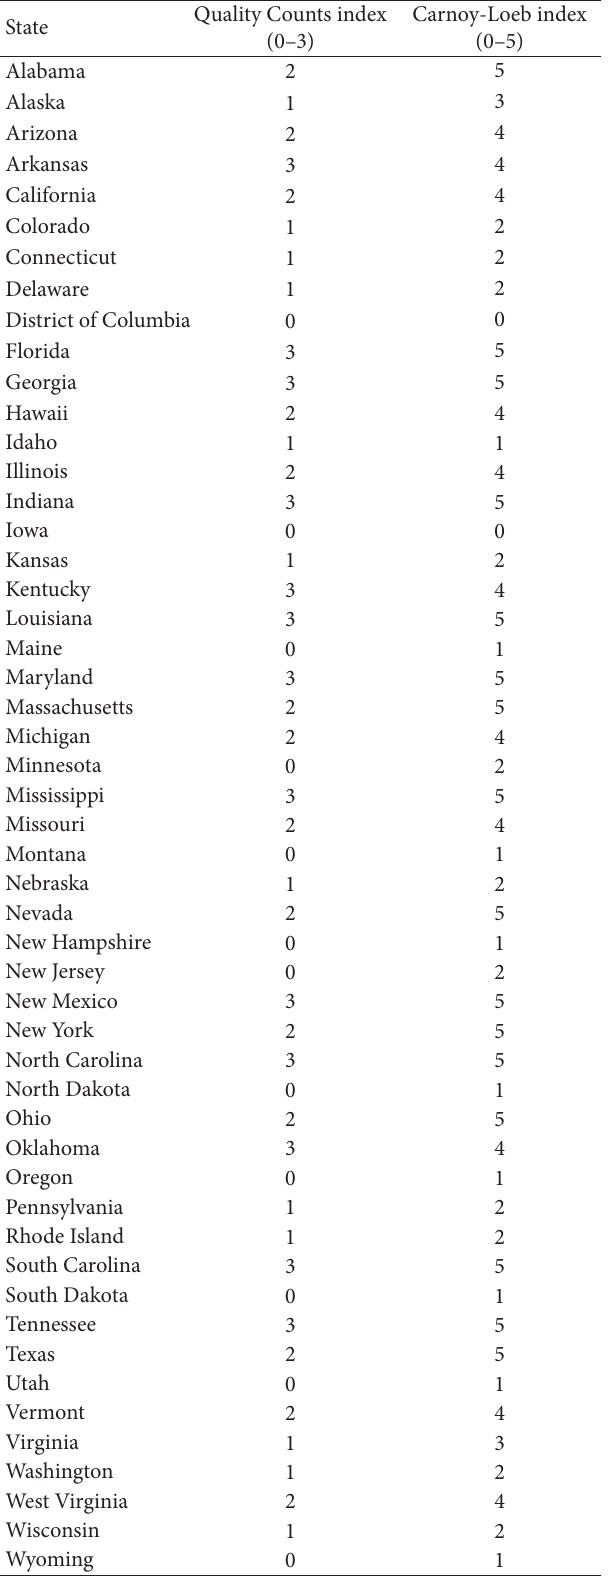
demographic, socioeconomic, and geographic factors.